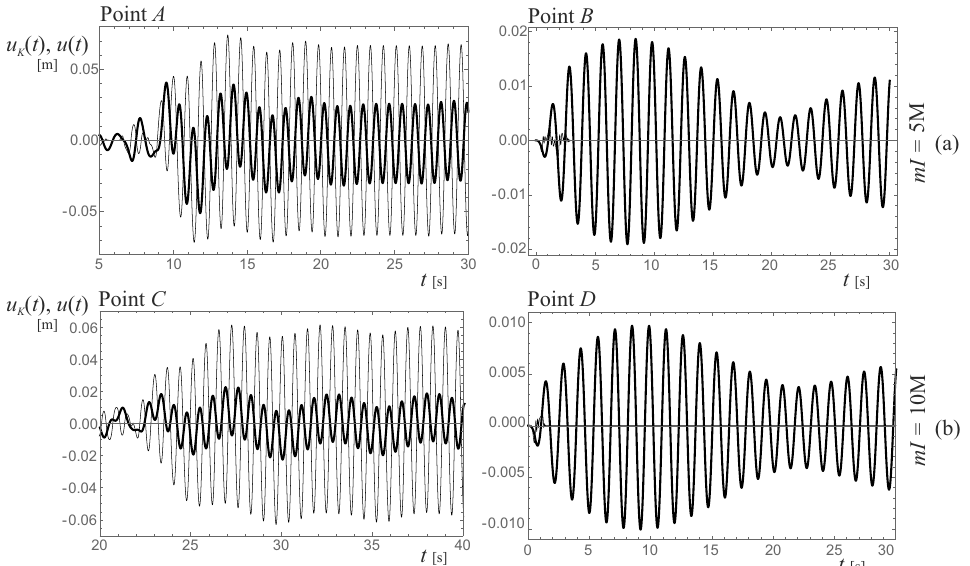
Figure 4. Time histories of the displacements u K ( t ) (thin lines) and u ( t ) (thick lines): ( a ) Time histories for coupled systems defined by points A and B of the frequency curve of Figure 3 ( m I = 5 M ); ( b ) Time histories for coupled systems defined by points C and D of the frequency curve of Figure 3 ( m I = 10 M ). Dimensions of the rigid block: 2 b = 0.6 m and λ = 5 ( r = 0.9423, T aux = 0.5 T b , m = 0.05 M , u y = 1/3 u cr , ψ =